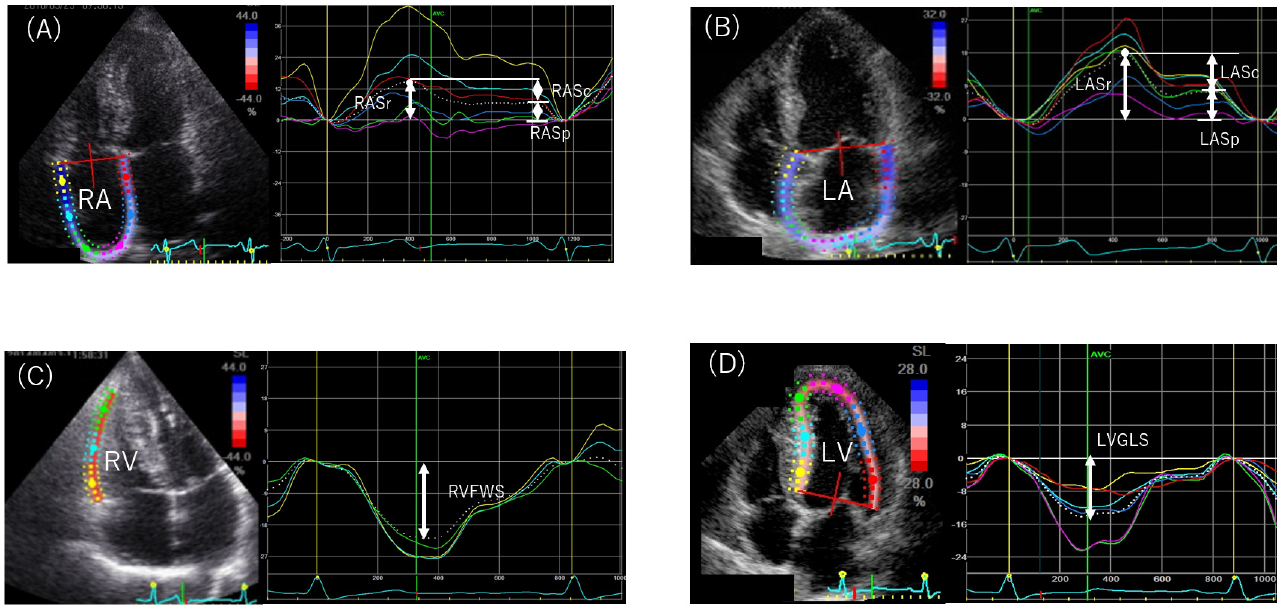
Figure 5. Analysis of longitudinal strain in a 4-chamber view. Dotted lines depict the average curve of the six segments. ( A , B ): The first positive peak of the curve is the peak atrial strain during ventricular systole, measured at the end of the reservoir phase (RASr and LASr). The peak defection is followed by a plateau and peak atrial strain in late diastole at the onset of the P wave on the electrocardiogram, just before the active atrial pump (RASp and LASp) begins. RA conduit (RASc) is calculated as the difference between RASr and RASp. LA conduit (LASc) is calculated as the difference between LASr and LASp. ( C , D ): Longitudinal strain of RV and LV was analyzed as the average of negative peak strain (RVFWS and LVGLS). RA, right atrium; LA, left atrium; RV, right ventricle; LV, left ventricle; RVFWS, right ventricular free wall longitudinal strain; LVGLS, left ventricular global longitudinal strain.